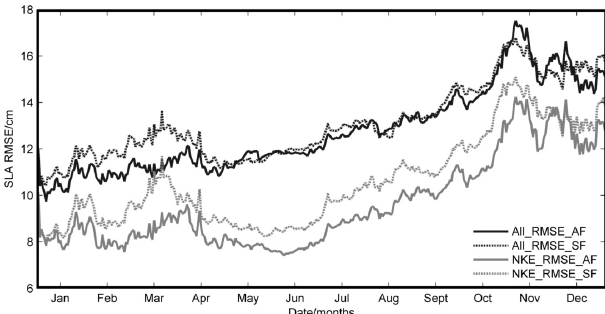
Figure 9. Temporal evolution of SLA RMSE (in meters). RMSE computed with the AVISO dataset for the AF (solid line) and SF (dotted line). The black line represents the RMSE in the entire do- main and the gray line represents the RMSE in the region without the Kuroshio Extension